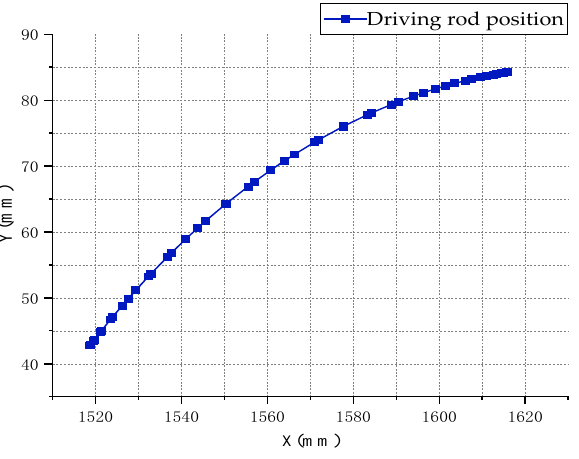
Figure 3. Position of drive rod.